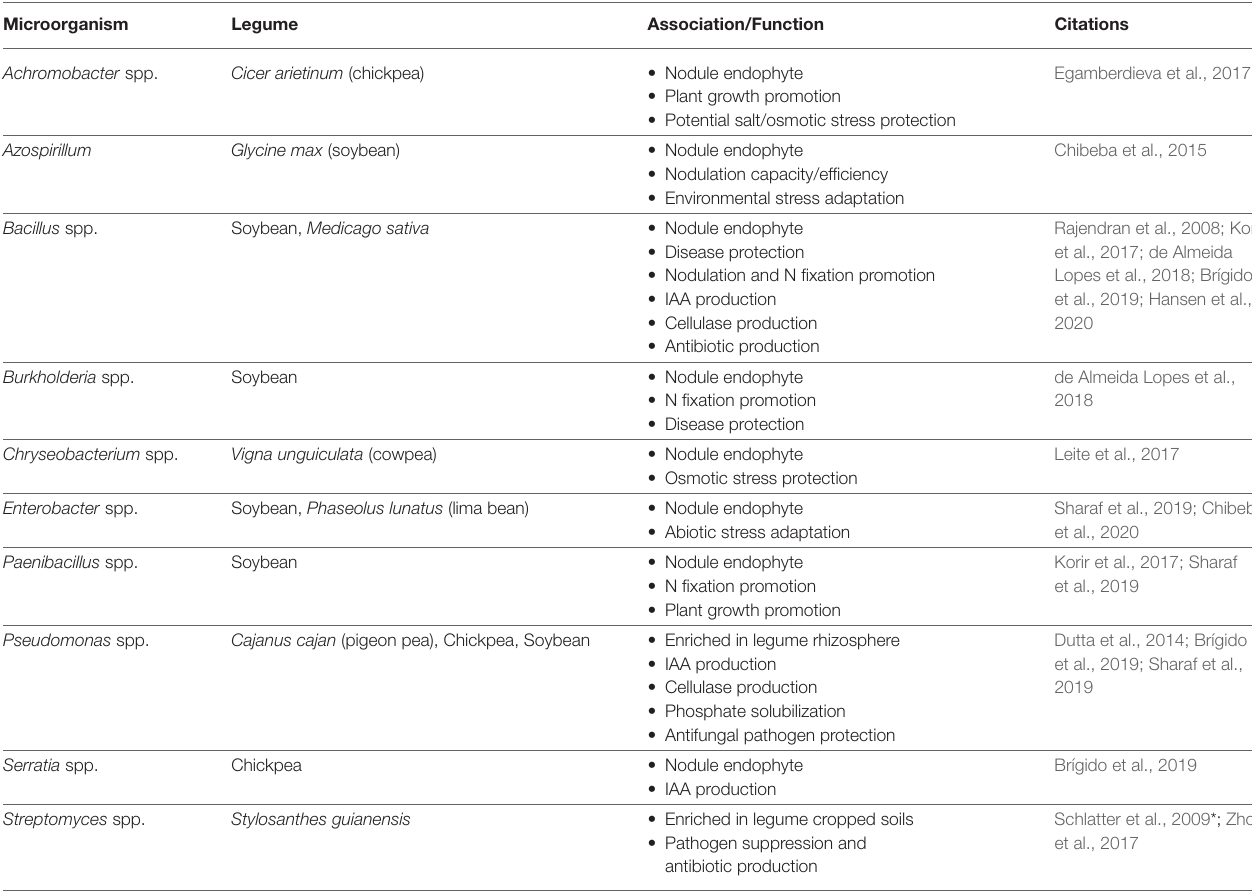
TABLE 1 | Selected legume-associated bacteria with confirmed and hypothetical functions.